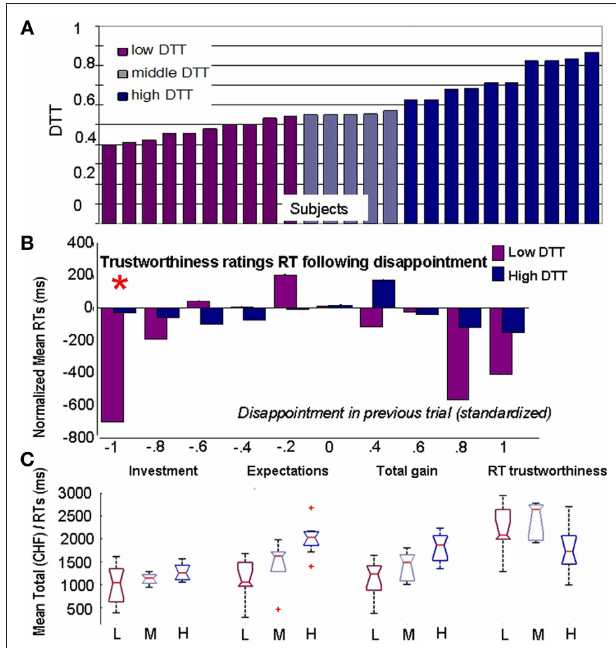
FiGurE 4 | impact of disappointment sensitivity on behavior. (A) Segregation of the subjects on the basis of behavior. Disappointment Tolerance Thresholds are shown on y -axis. (B) Mean (over subjects) reaction times after standardization by individual mean reaction times over the whole task. The disappointment in previous trial was individually normalized and divided into 10 bins of equal length. (C) Boxplots showing the distributions of values for total investment, total expectations, total gains, and mean reaction times (RTs) for trustworthiness ratings when subjects are grouped by DTT values. Subjects who reduce their expectations after disappointment take faster decisions but expect less and gain less while investing the same as subjects who are less sensitive to